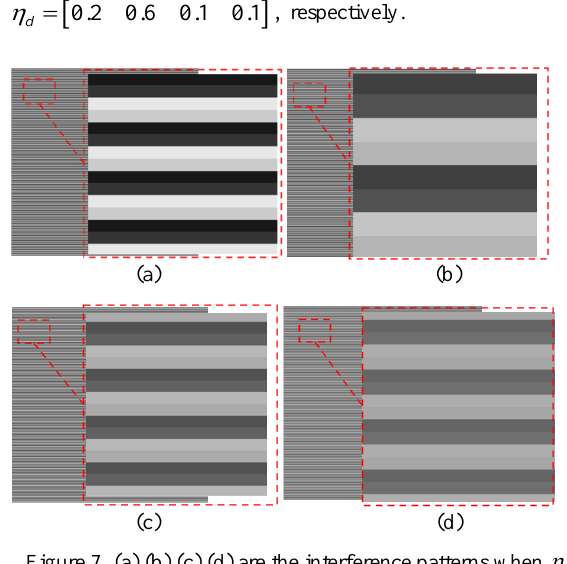
Figure 7. (a) (b) (c) (d) are the interference patterns when  takes four different sets of